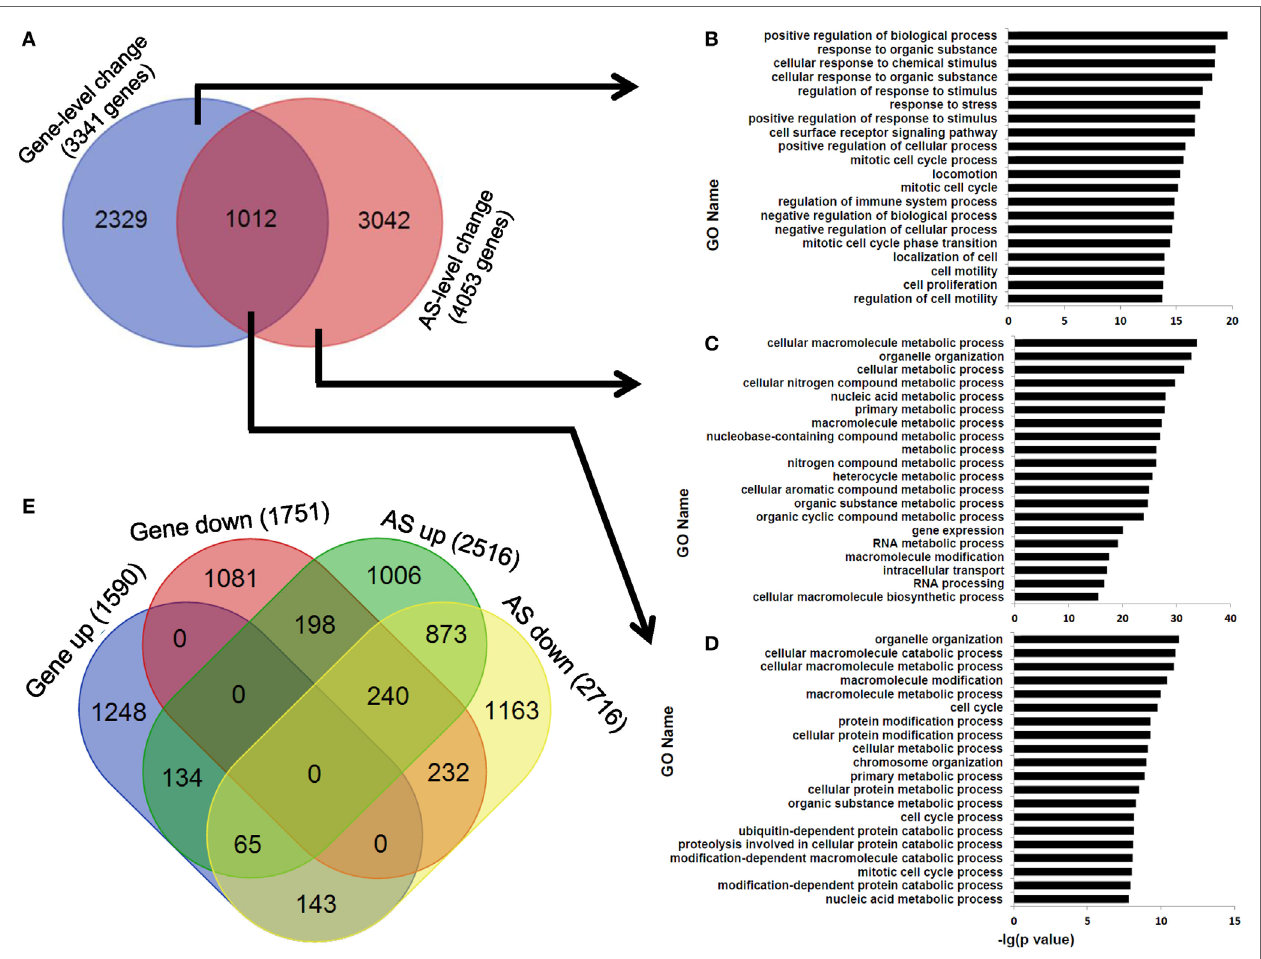
FigUre 8 | AS is not a major contributor to gene expression-level changes between paired pCD8 and dCD8 T cells. (a–D) Venn diagram (a) and functional enrichment analysis (B–D) for the genes showing significant AS-level and expression-level changes between in human dCD8 and pCD8 T cells. The top 20 GO terms (biological process) were indicated (B–D) . (e) Venn diagram of genes showing AS-level and/or expression-level upregulation and/or downregulation, in dCD8 T cells with respect to autologous pCD8 T cells. The five types of AS events including SE, MXE, A5SS, A3SS, and RI were combined together. Abbreviations: AS, alternative splicing; up, upregulated; down, downregulated; pCD8 T, peripheral blood CD8 + T; dCD8 T, decidual CD8 + T; GO, gene ontology; SE, skipped exon; MXE, mutually exclusion exons; A5SS, alternative 5’ splice site; A3SS, alternative 3’ splice site; RI, retained